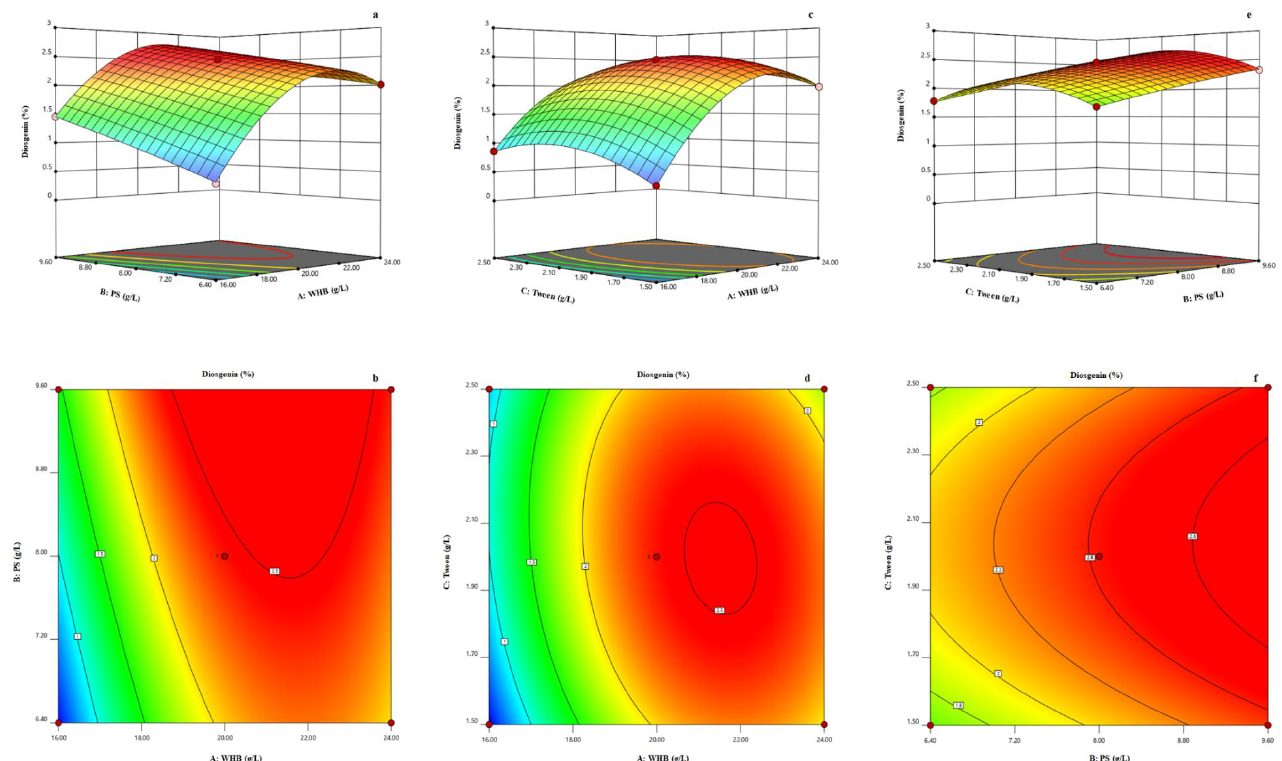
Figure 3. Contour maps and response surface plots in the BBD. ( a ) Mutual interaction between wheat bran and phosphate based on response surface plot. ( b ) Mutual interaction between wheat bran and phosphate based on contour map. ( c ) Mutual interaction between wheat bran and Tween-80 based on response surface plot. ( d ) Mutual interaction between wheat bran and Tween-80 based on contour map. ( e ) Mutual interaction between phosphate and Tween-80 based on response surface plot. ( f ) Mutual interaction between phosphate and Tween-80 based on contour map.